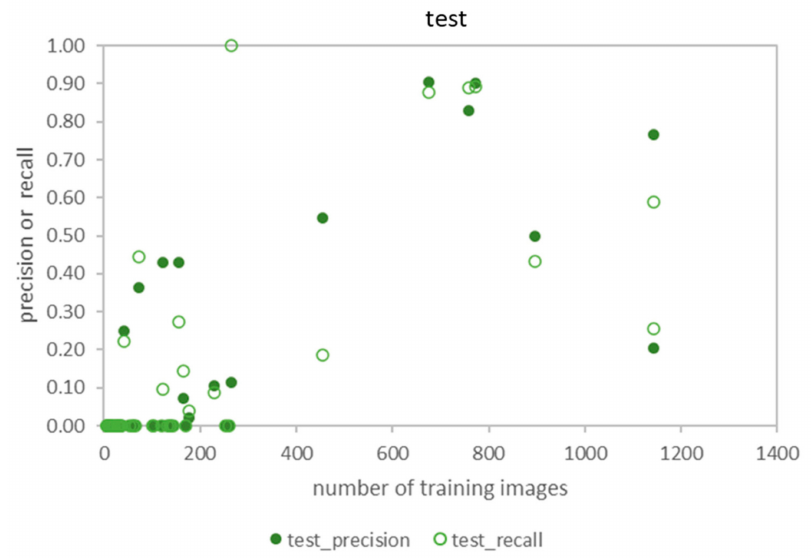
Figure 11. Relationship between precision or recall accuracy and number of training images. From top to bottom, the accuracy of validation 1, validation 2 and the